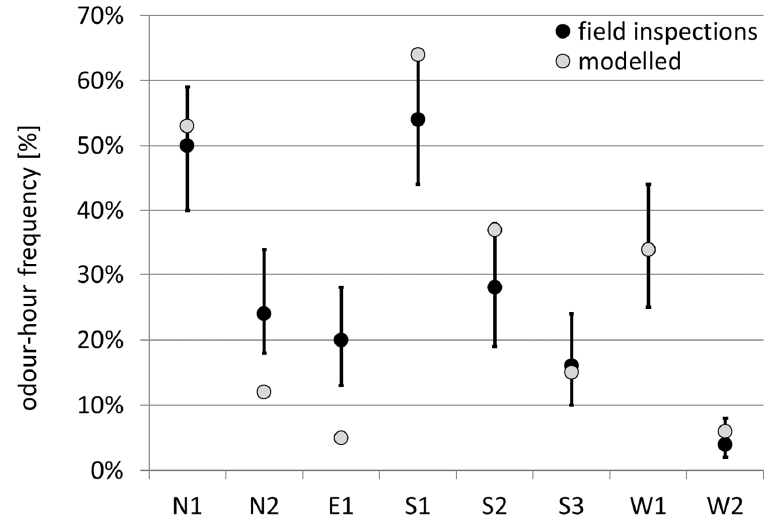
Figure 5. Observed and modelled odour–hour frequencies in the vicinity of the fattening piggery. Vertical bars indicate the 95% confidence interval of the observations.